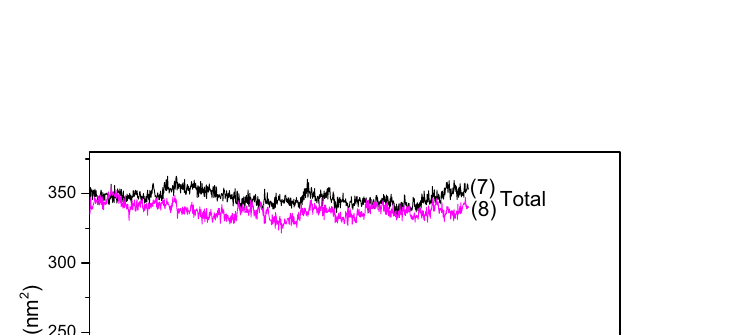
Figure 7. Interaction as revealed by potentials for the systems (7) and (8) from 200–300 ns. ( a ) The short range LJ potential (LJ-SR) of ions (Ca 2+ , Na + ) and the carboxylate COO − ; ( b ) the short range coulomb potential (Coul-SR) ions (Ca 2+ , Na + ) and the carboxylate COO − .